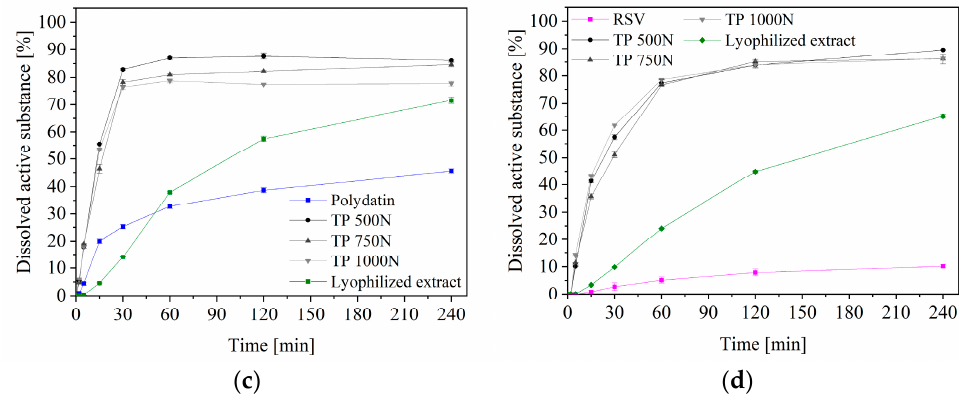
Figure 3. Dissolution pro fi les of polydatin ( a ) and resveratrol ( b ) from the nano fi ber tablets, and polydatin ( c ) and resveratrol ( d ) from the powder tablets, in arti fi cial saliva solution at pH 6.8. To be tt er illustrate the di ff erences in the release pro fi les, in the absence of statistically signi fi cant di ff erences between the pro fi les for di ff erent compression forces, the pro fi les for TP and TN were averaged, and are presented in Figure 4.